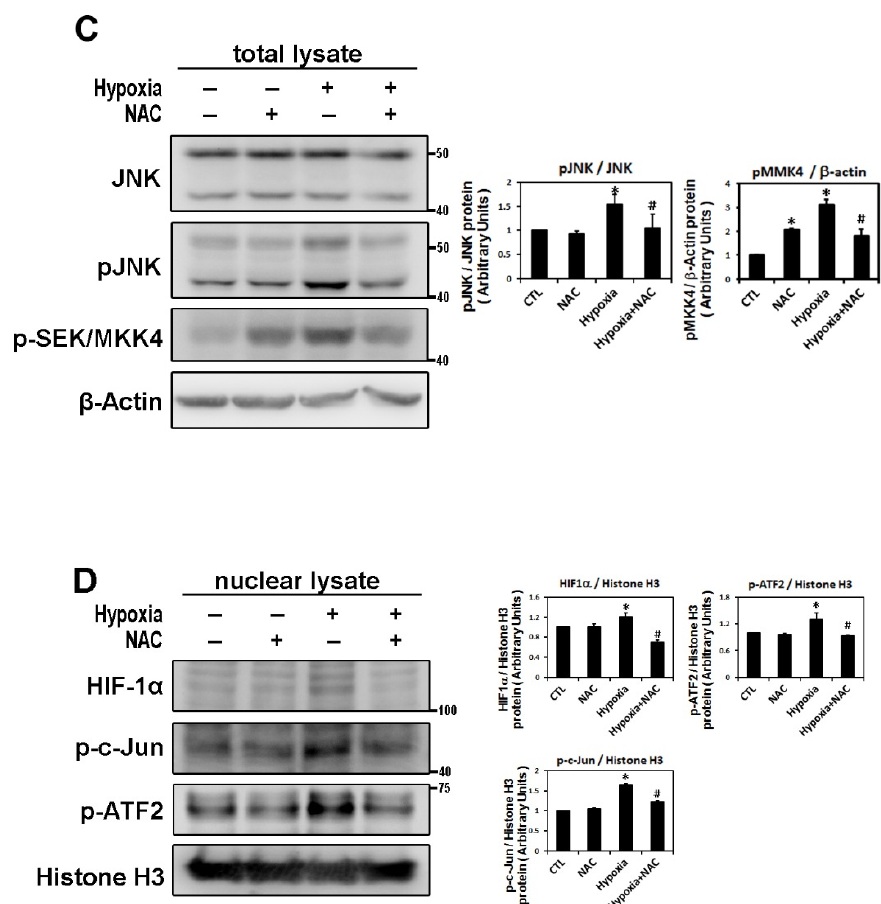
Figure 6. Reactive oxygen species (ROS) module hypoxia-induced HIF-1 α , JNK signal pathway and fibrosis-related proteins expression in HL-1 cells. Panel A : The ROS levels were assessed with dichlorofluorescin diacetate (DCFH-DA) in HL-1 cells that were pre-incubated with NAC (2 mM) or vehicle only (CTL) for 2 h, then subjected to normoxia (5% CO 2 and 95% air) or hypoxia (1% O 2 ) stimulation for 6 h. The bar graph shows the value of each sample relative to that of control cells under normoxic (vehicle only) or hypoxic conditions. The data are mean ± SEM ( n = 4 per group, * p < 0.05 vs. control; # p < 0.05 vs. hypoxia) from four independent experiments. Panel B and C : Representative Western blots and levels of fibrosis-related proteins (COL1A, COL3A, TGF- β 1, α -SMA), JNK, phosphorylated JNK and MKK4 for whole cell lysate in HL-1 cells pre-treated with or without NAC (2 mM) for 2 h, then treated under hypoxic (1% O 2 ) or normoxic conditions for 6 h. The data are mean ± SEM (* p < 0.05 vs. control; # p < 0.05 vs. hypoxia) from at least three independent experiments. Panel D : Representative Western blots and levels of HIF-1 α , fibrosis-related proteins (COL1A, COL3A, TGF- β 1, α -SMA) in nuclear lysates of HL-1 cells pre-treated with or without NAC (2 mM) for 2 h, then treated under hypoxic stress (1% O 2 ) or normoxic conditions for 6 h. The bar graph shows the value of each sample relative to that of control cells under normoxic (vehicle only) or hypoxic conditions. The data are mean ± SEM (* p < 0.05 vs. control; # p < 0.05 vs. hypoxia) from at least three independent experiments.